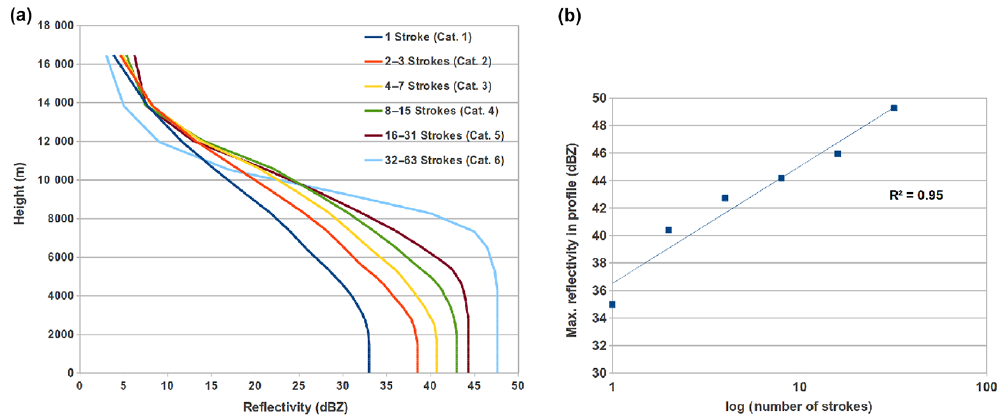
Figure 3. Panel (a) shows Rad-Lig relationship profiles (smoothed) from Finland NORDLIS-LLS, calculated using the dataset from summer 2014. Profiles are divided into binned categories of strokes, with a temporal resolution of 5min and spatial resolution of 3km. Panel (b) shows profiles’ max reflectivity values vs. lightning rate (logarithmic scale of